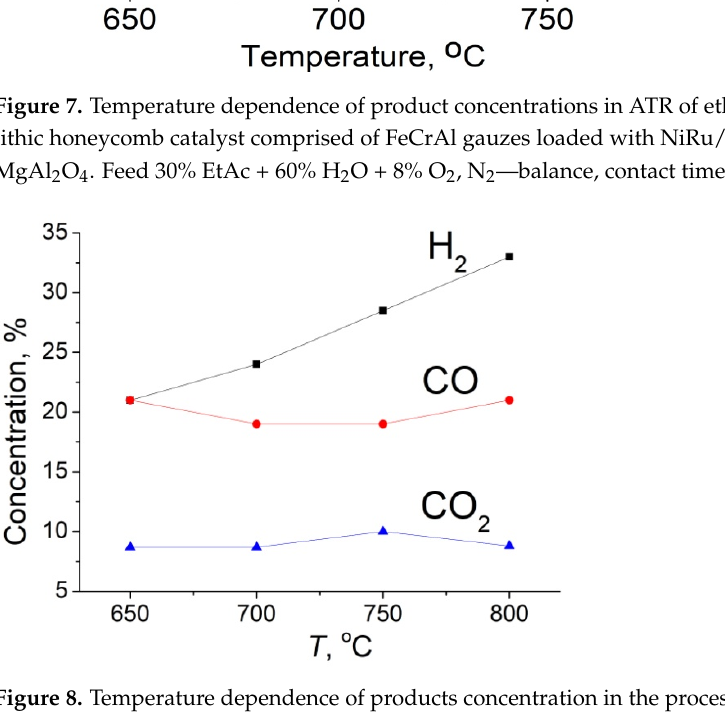
Figure 9. Dependence of products concentrations on oxygen content in the feed in the process of turpentine oil autothermal reforming on 3.4% LaNiPt/La-Ce-Zr-O/Fechraloy thin foil honeycomb at 800 °C. Feed 7% turpentine + 40% H 2 O+O 2 +N 2 , contact time 0.5 s.